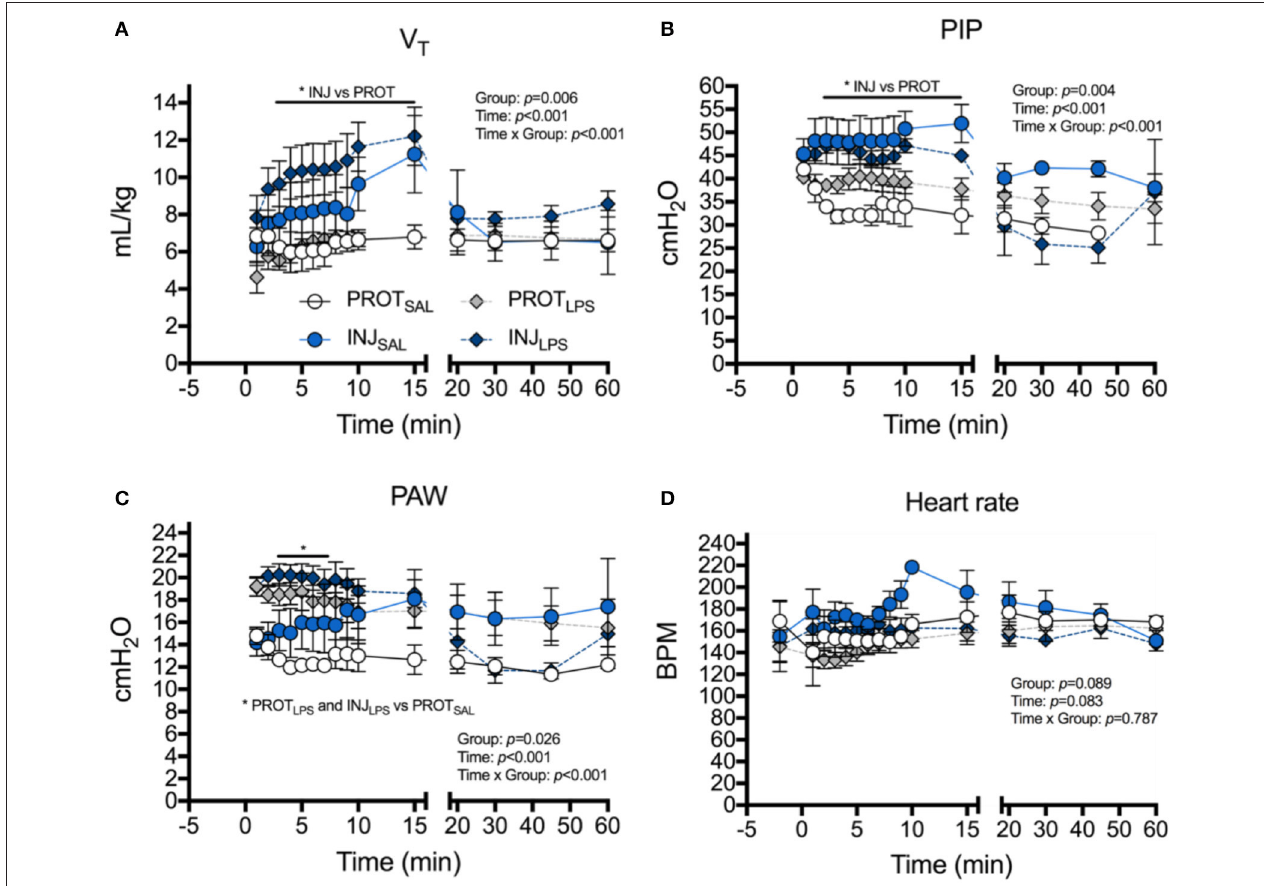
FIGURE 1 | Effects of ventilation strategy and LPS exposure on ventilator requirements and heart rate. Changes in tidal volume (V T ), (A) , peak inspiratory pressure (PIP) (B) , mean airway pressure (PAW) (C) and heart rate (D) , in the PROT SAL (white circles), INJ SAL (blue circles), PROT LPS (gray diamonds) and INJ LPS (dark blue diamonds) lambs. PROT SAL , N = 5; PROT LPS , N = 6; INJ SAL , N = 6; and INJ LPS , N = 5. * p <